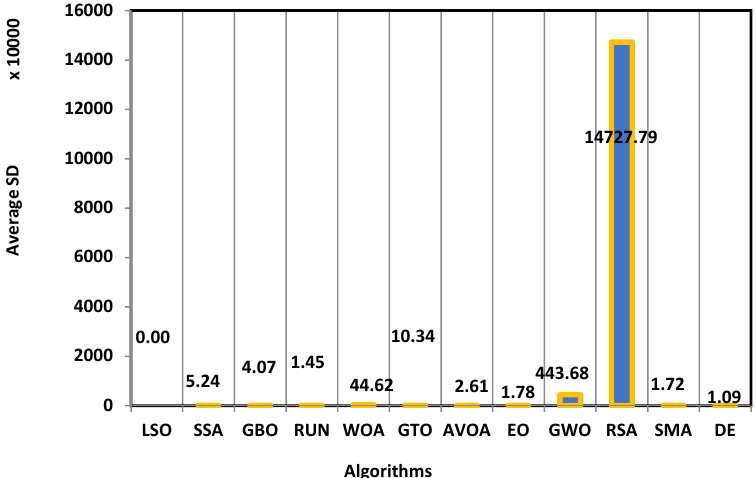
Figure 12. Average SD of each optimizer on all CEC2017.